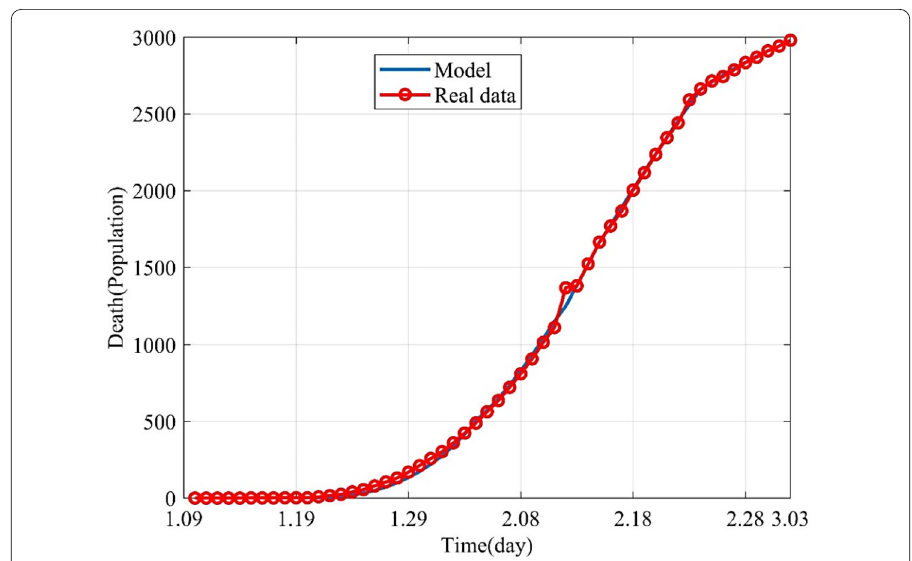
Figure 6 Dynamic trends of the death. The blue line represents the simulation of SEIR model, and the red line represents the data issued by NHCC